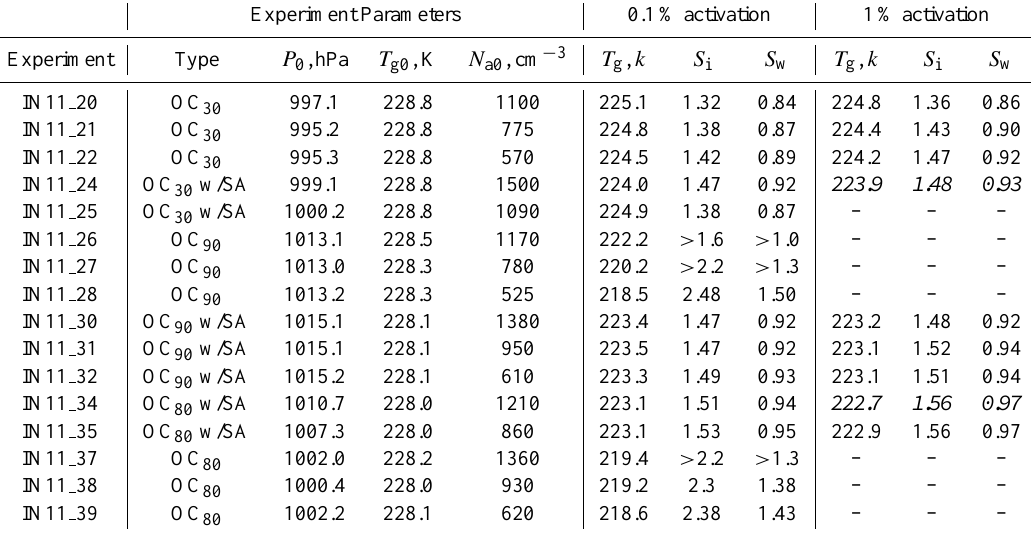
Table 2. Same as Table 1 but using mini-CAST propane flame soot. Values in italics are extrapolated from the 0.1% activation data. Experiment Parameters